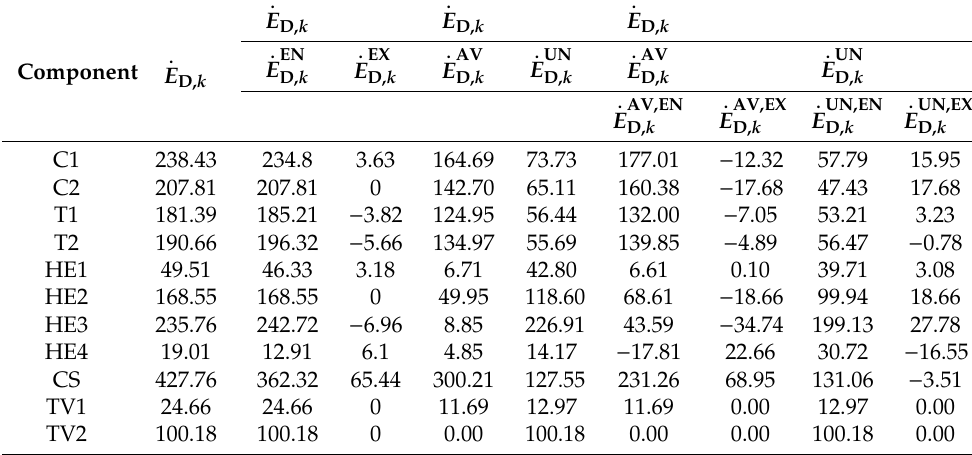
Table 5. Advanced exergy analysis results (kW).